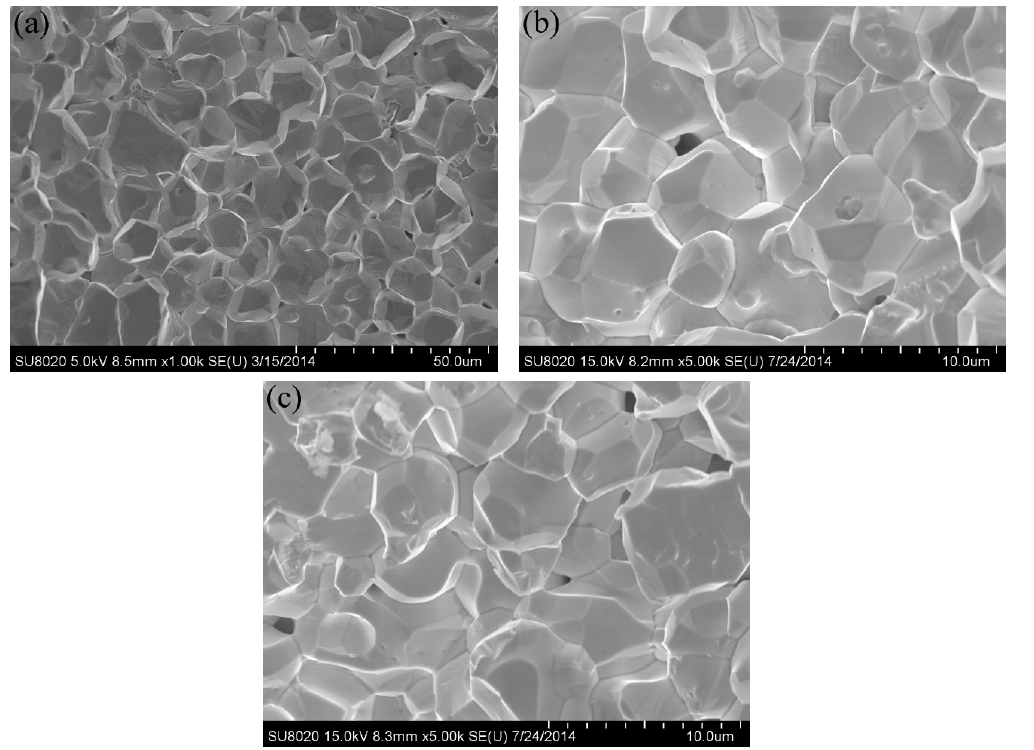
Figure 7. SEM micrographs of the fracture surfaces after tensile test at room temperature for: ( a ) pure